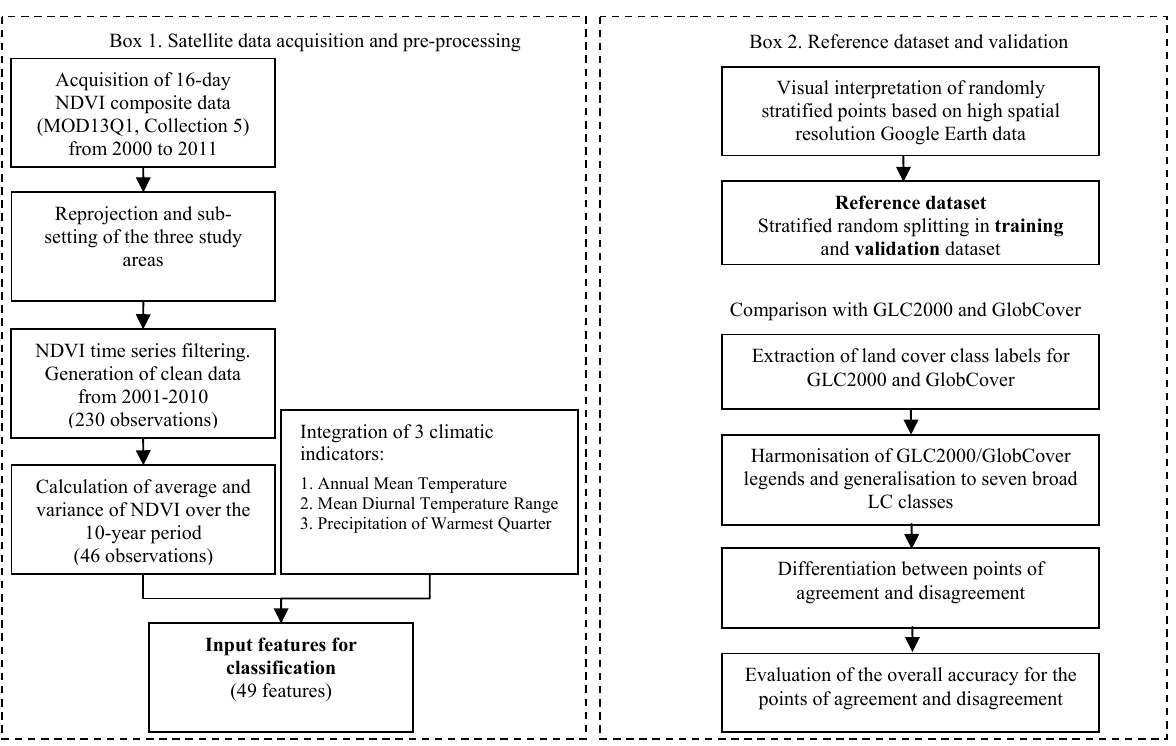
Figure 1. Workflow of the proposed land cover classification and validation process. The description of satellite data acquisition and pre-processing is reported in Box 1. Box 2 presents the processing of the reference dataset and the comparison with GLC2000 and